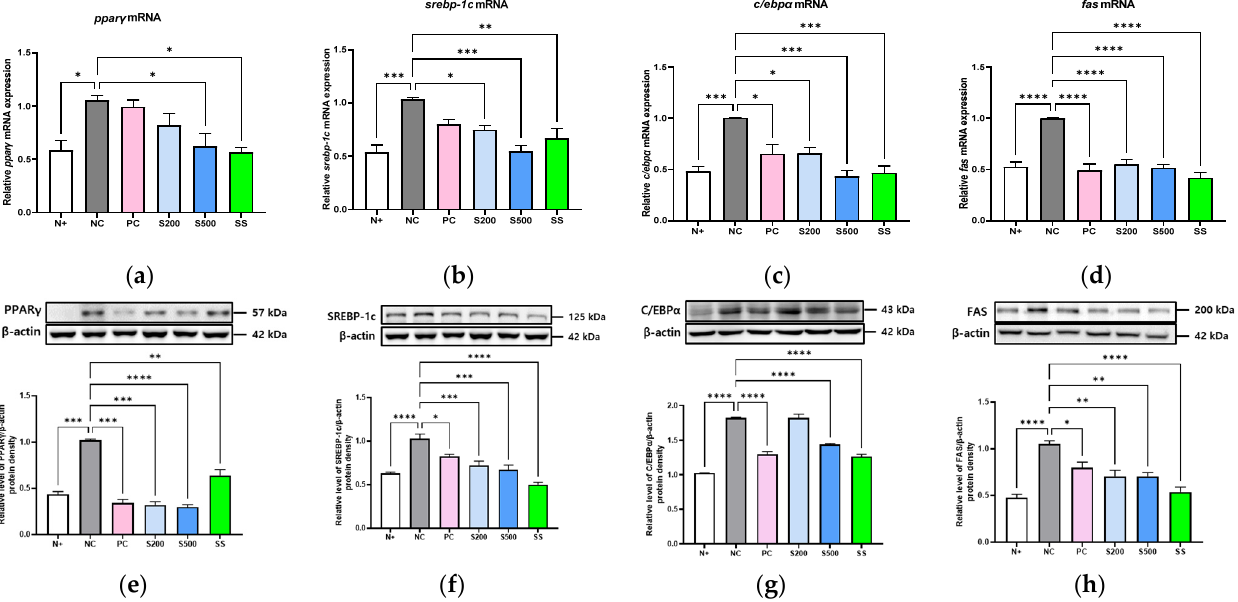
Figure 2. Stevia and stevioside attenuate adipogenic-related genes and proteins in db/db mice. Mice were orally administered saline (N+ and NC), saline with 200 mg/kg/day metformin (PC), saline with 200 or 500 mg/kg/day stevia (S200 and S500), and saline with 40 mM/kg/day stevioside (SS) for 3 weeks. ( a , e ) Peroxisome proliferator-activated receptor gamma (PPAR γ ). ( b , f ) Sterol regulatory element-binding transcription factor-1c (SREBP-1c). ( c , g ) CCAAT/enhancer binding protein alpha (C/EBP α ). ( d , h ) Fatty acid synthase (FAS). All data are presented as the mean ± SE, n = 6 and represent results from three independent experiments. * p < 0.05, ** p < 0.01, *** p < 0.001, and **** p < 0.0001.